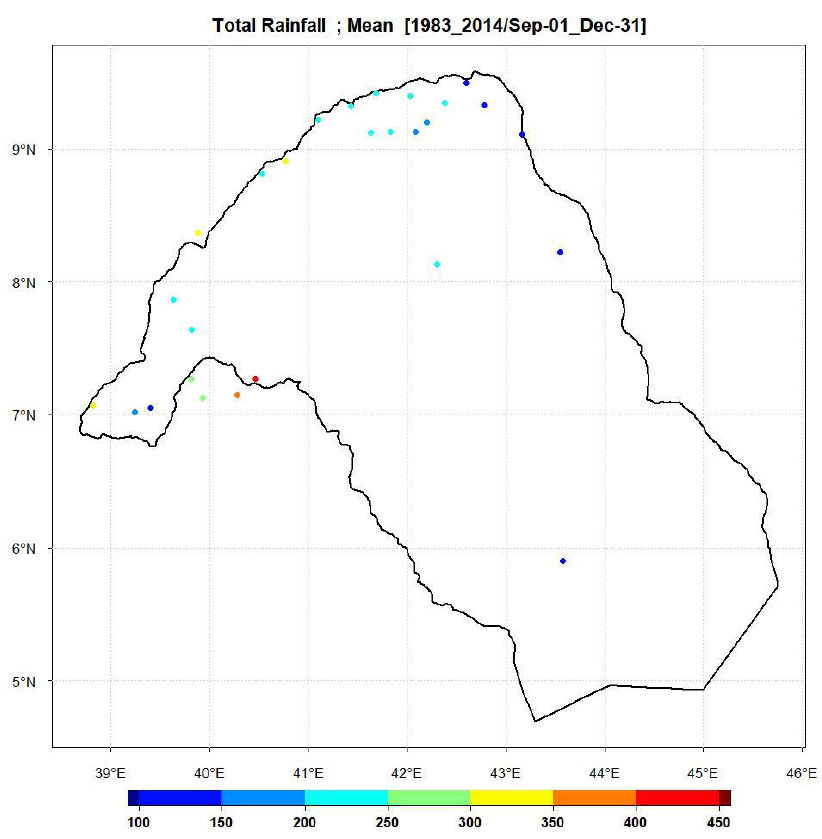
Figure 2. Annual rainfall in Wabi Shebelle River Basin .